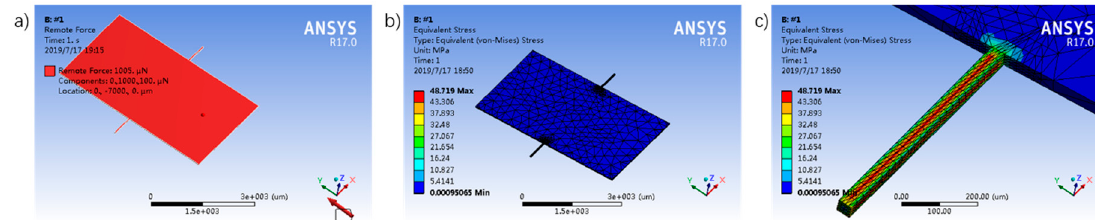
Figure 4. FEA on teeter-totter structure. ( a ) Loads applied on the structure—100 μ N lateral force and 1 mN normal load; ( b ) meshing result, locally refined; ( c ) simulation result of the max equivalent stress.